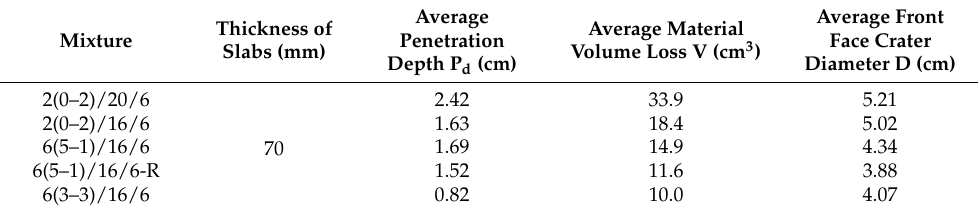
Table 9. Projectile impact results for 70 mm thickness slabs for each